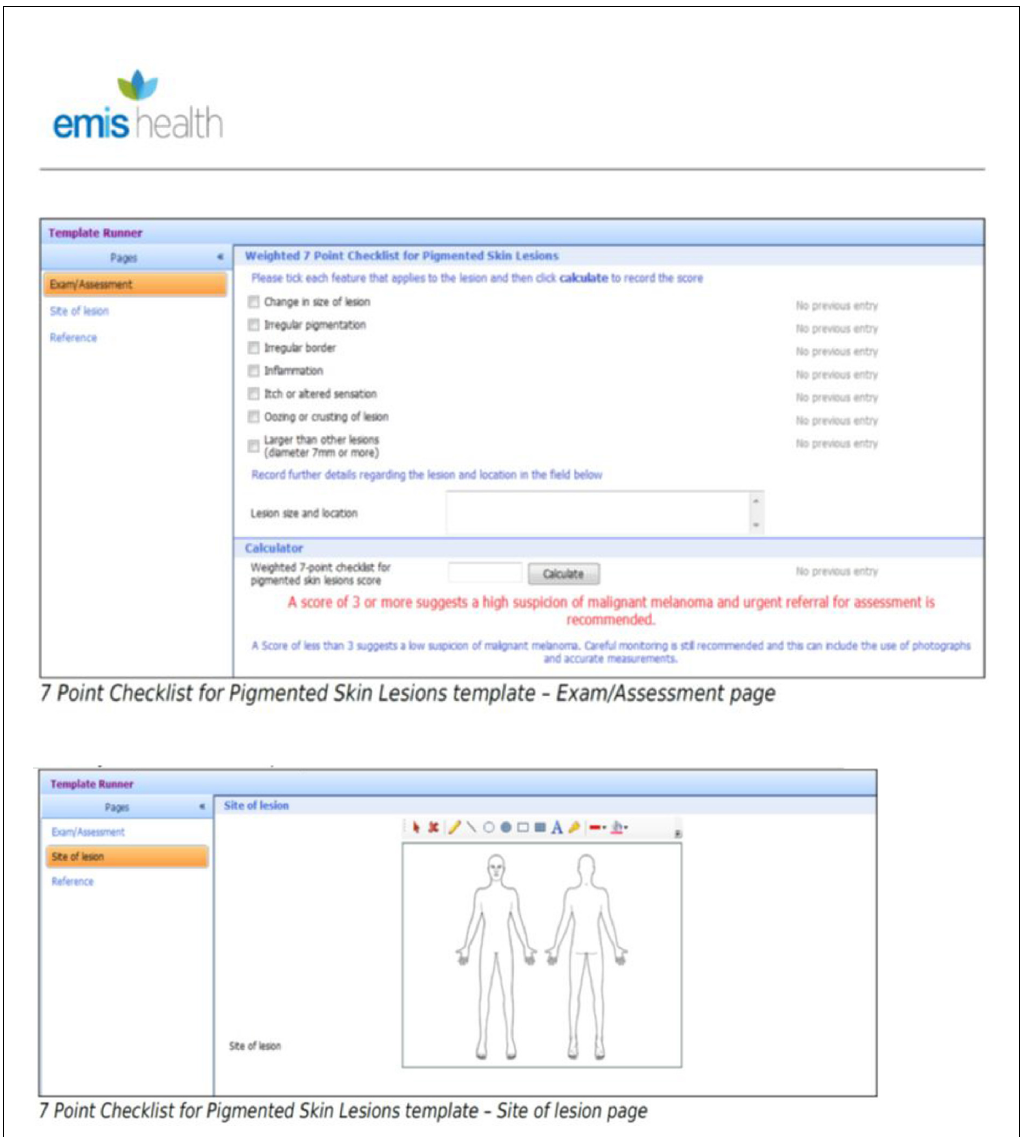
Figure 1. Screenshots of EMIS software to show electronic clinical decision support for melanoma. eCDS = electronic clinical decision support.